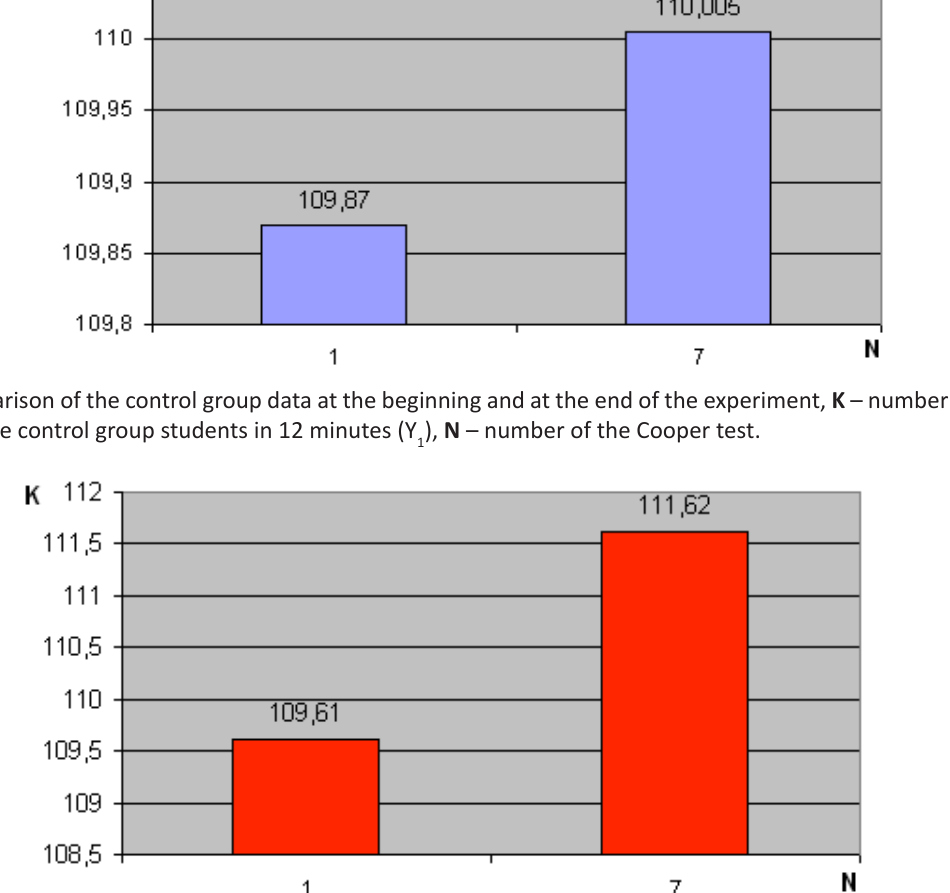
Fig. 5. Comparison of the data of the experimental group at the beginning and at the end of the experiment, K – is the number of meters passing by the students of the experimental group in 12 minutes (Y